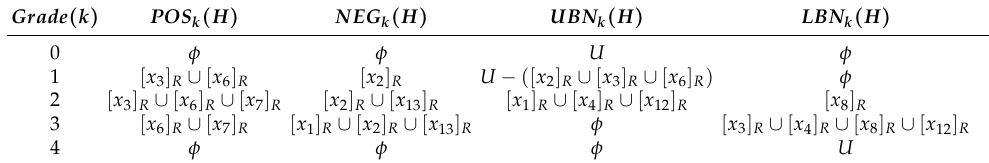
Table 5. Related results of the GRS-HFEn model.